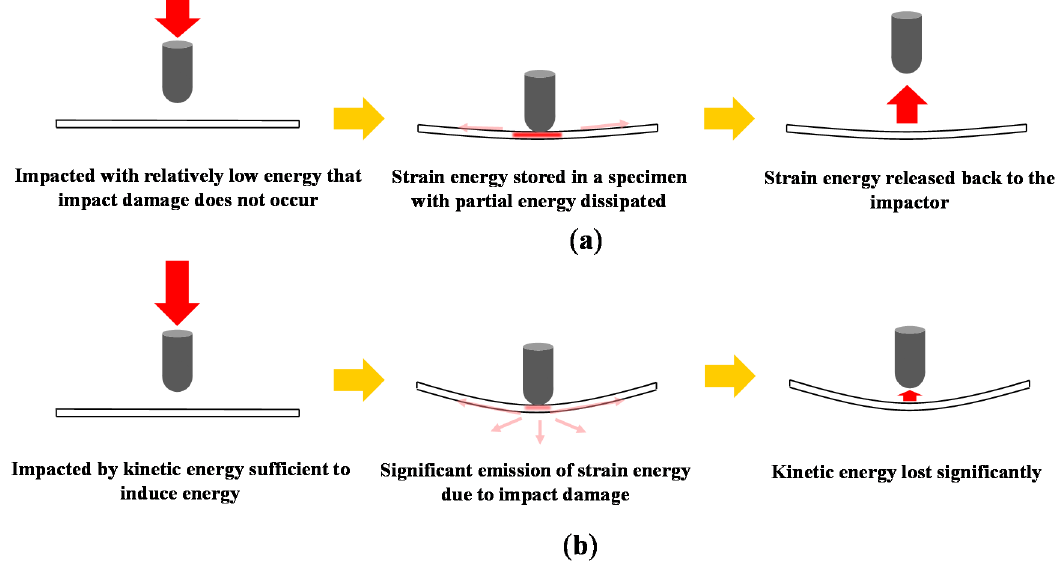
Figure 7. Schematics of impact scenarios: ( a ) the impact scenario where the impacted specimen is intact and ( b ) the impact scenario where damage occurs.